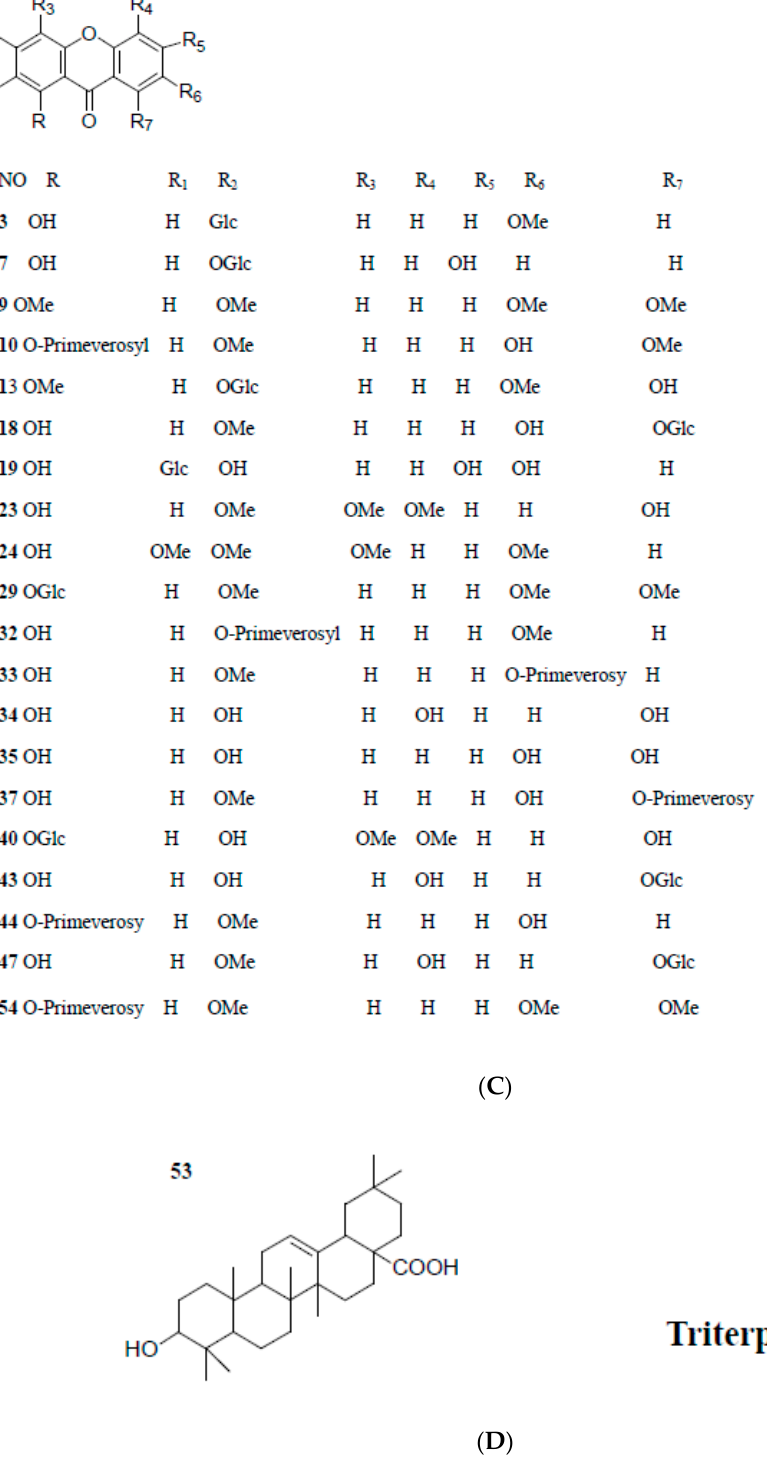
Figure 1. The structures of compounds identified in crude and wine-processed Gentiana radix : ( A ) iridoids; ( B ) flavonoids; ( C ) xanthones; ( D ) triterpenoid.